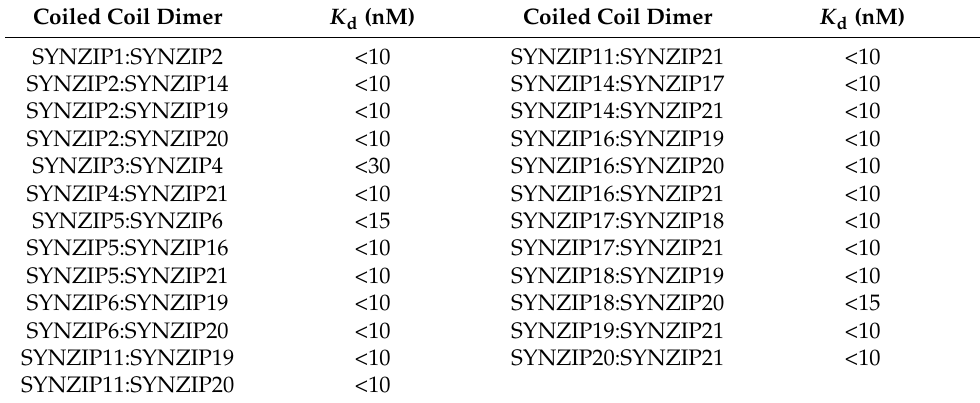
Table 1. Binding dissociation constant ( K d ) of SYNZIP dimers as reported in Thompson et al. [20]. Coiled Coil